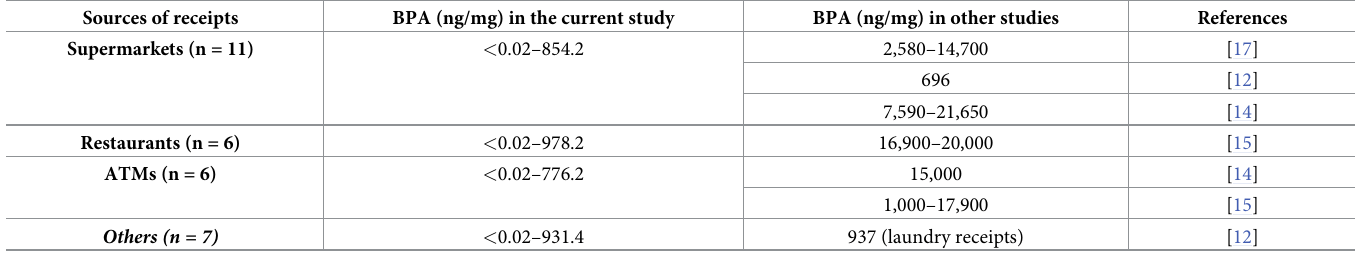
Table 1. BPA concentrations in thermal papers investigated in the current study and in thermal papers from similar sources reported in global studies.